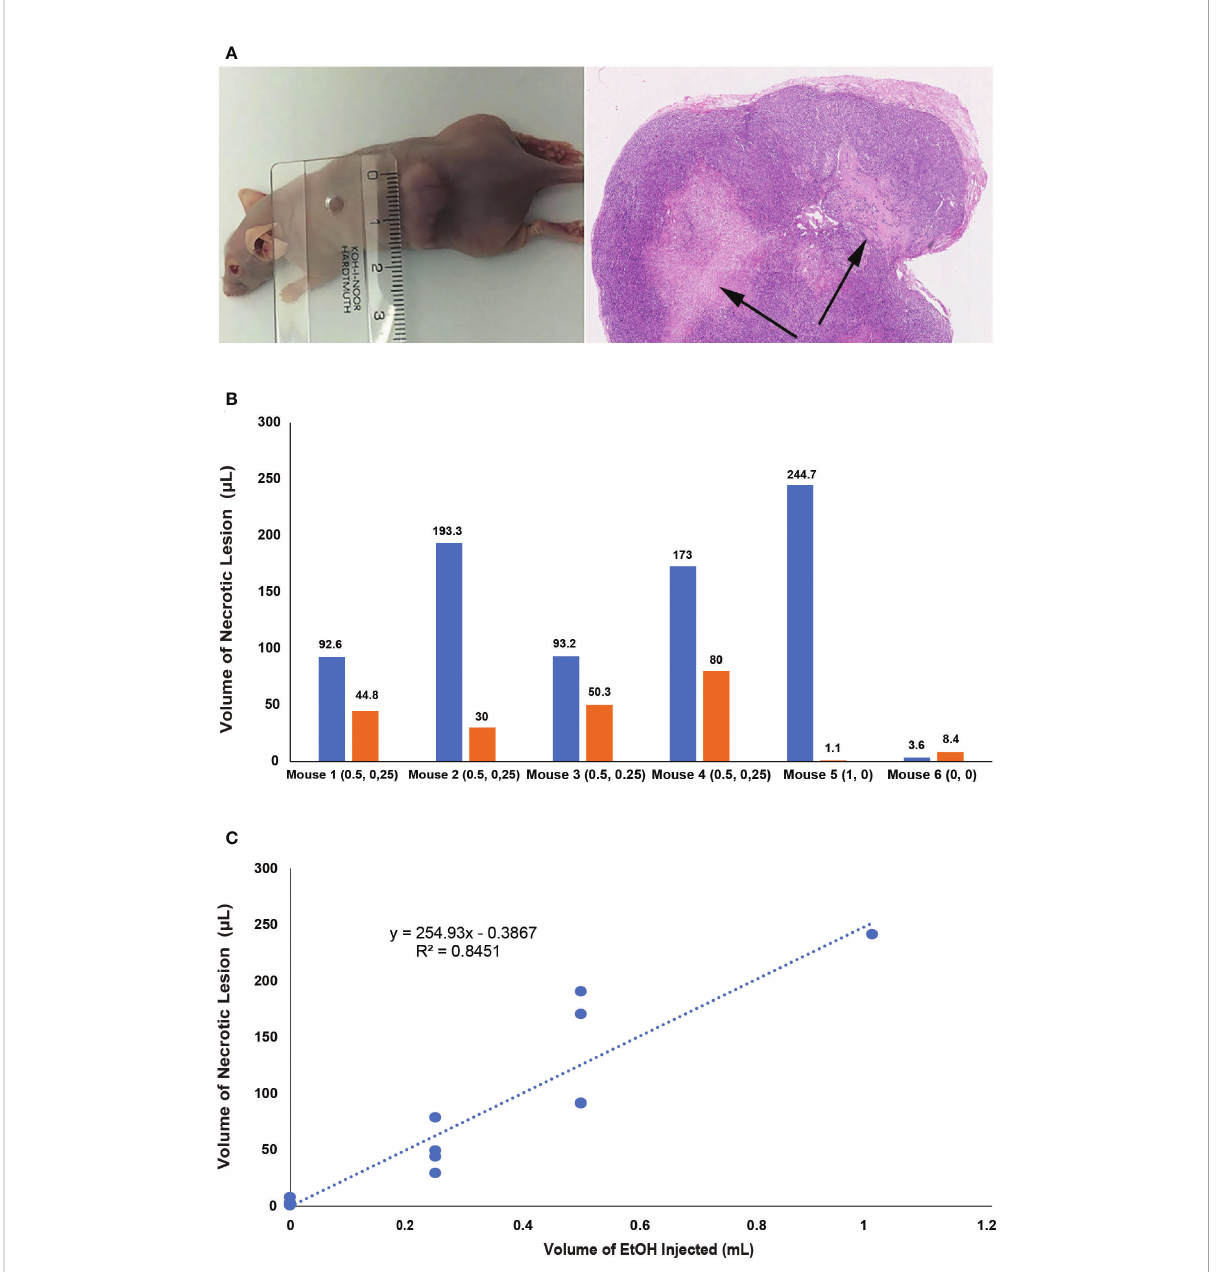
FIGURE 6 (A) Left. The xenograft of human prostate cancer localized subcutaneously in the back of athymic mice. Right. Section of the prostate cancer tissue two hours after EtOH injection. Necrotic lesions are marked by arrows. (B) Graph summarizing the volume of tissues lesions in human prostate cancer xenografts 2 hours post injection. The volume injected (mL) is listed in brackets under x axis, number above each bar represents the volume of the lesion. (C) Plot demonstrating the correlation of the volume of ethanol and the volume of necrotic lesion in 3 controls and 9 experiments where ethanol was injected trough 1 cm long porous